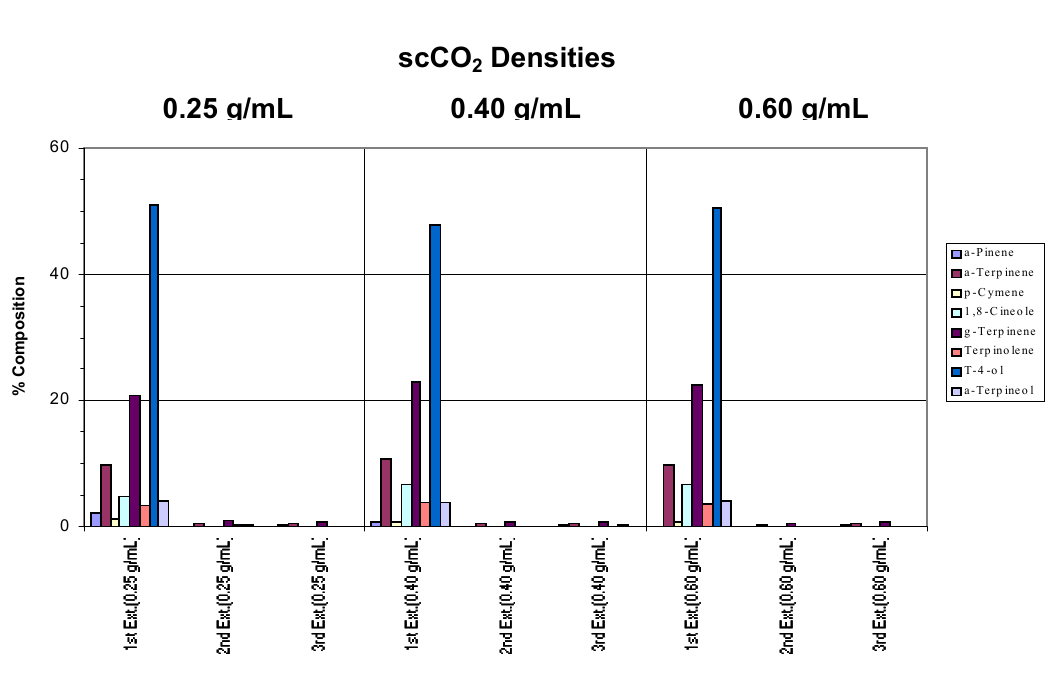
Figure 5. Recovery of target analytes from crushed fresh leaves using a chamber temperature of 110